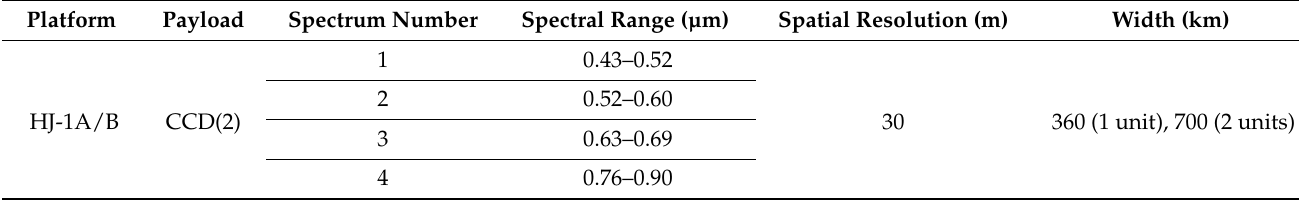
Table 3. HJ-1A/1B satellite 4 spectrum